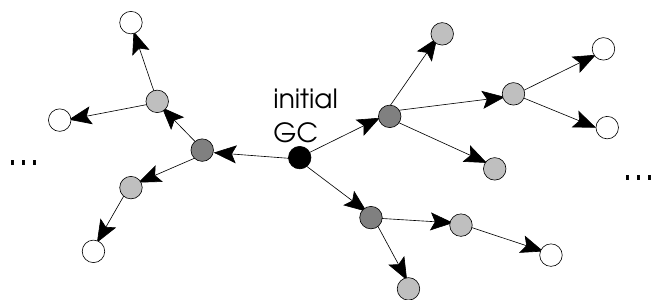
Figure 1. Transitive exploration of the space of Gray Codes (GCs) from the initial black code. Each dot represents one GC. The color gets lighter at each additional transform.